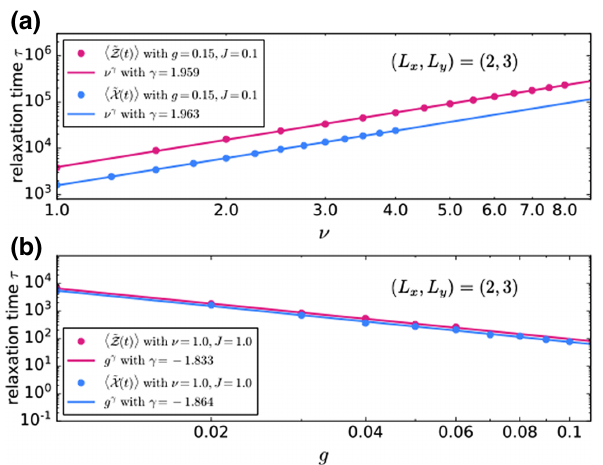
FIG. 5. The scaling behavior of relaxation times τ Z and τ X . Scaling of the lifetimes τ Z (magenta data points) and τ X (blue data points) with the coupling parameters ν (a) and g (b) ˜ X ( extracted from scrutinizing the quench dynamics of (cid:6) t ) (cid:3) and (cid:6) ˜ Z ( t ) (cid:3) starting from initial product states, i.e., eigenstates of the respective logical operator. The lifetime τ Z ( X ) is then defined to ˜ X (cid:3) ˜ Z ( ˜ Z (cid:3) ˜ X ( [ (cid:6) ] is true for be the time where (cid:6) t ) (cid:3) = (cid:6) t ) (cid:3) = (cid:6) DE DE the first time. The coupling parameter ν governs the strength of the operators ˜ N X and ˜ N Z that count the number of vertex and plaquette excitations of the surface code whereas the parameter g is associated with the symmetry-violating perturbation V [see Eq. (29)]. The system size is again ( L x , L y ) = ( 2, 3 ) , the initial √ 3 to states are the same as those used in Fig. 4, and we use ξ = avoid resonances. The data points are plotted on a log-log scale and fits to power-law scaling are shown as solid lines. The pow- ˜ X ( ˜ Z ( ers extracted from the fits are 1.959 (1.963) for (cid:6) t ) (cid:3) [ (cid:6) t ) (cid:3) ] ˜ Z ( ˜ X ( and − 1.833 ( − 1.864) for (cid:6) t ) (cid:3) [ (cid:6) t ) (cid:3)